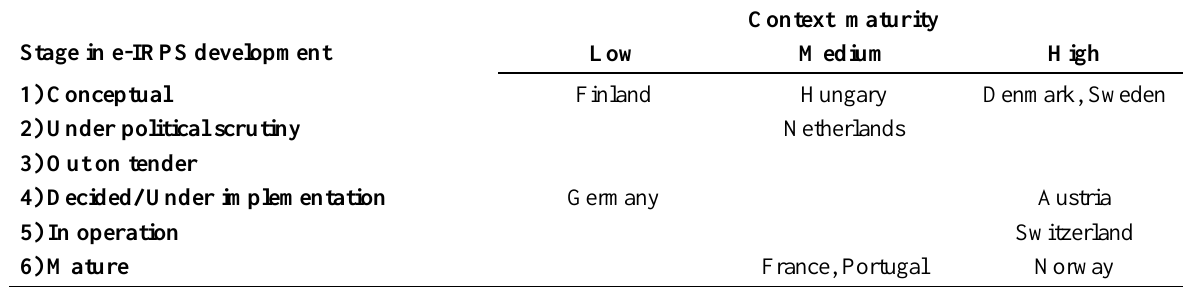
Table 1. Rating reversibility of national decisions on electronic IPRS scheme according to status in decision making process and degree of maturity of domestic